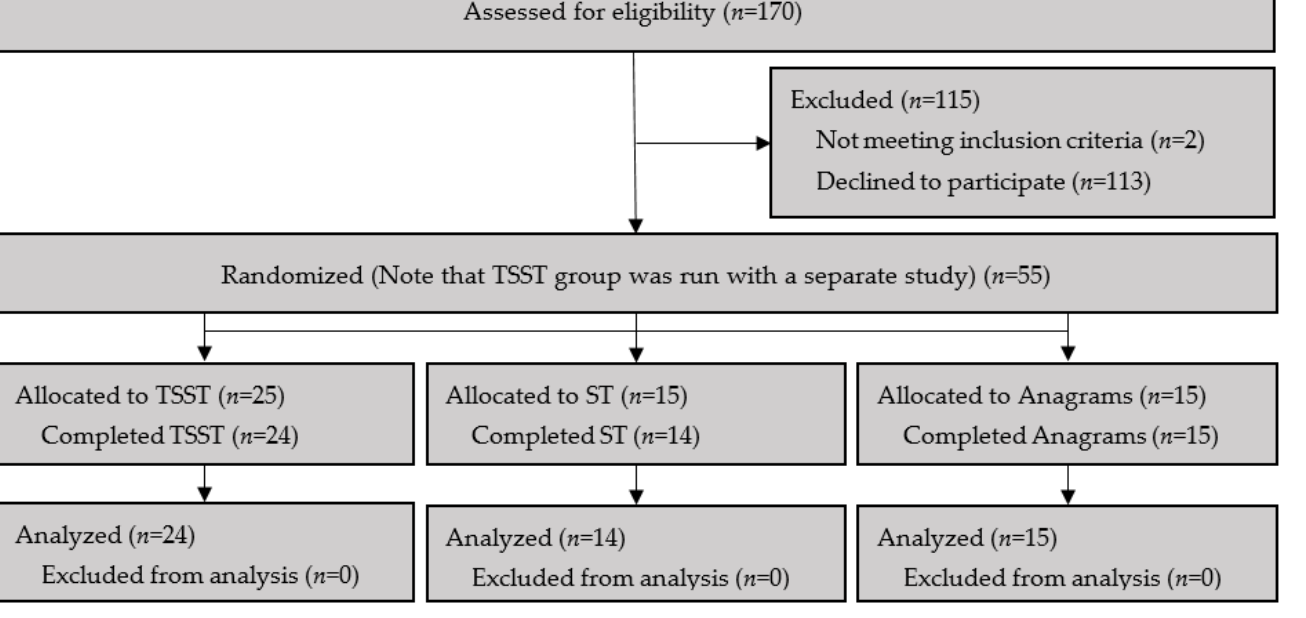
Figure 1. Reporting checklist for participants. Table 1. Participant descriptive characteristics.